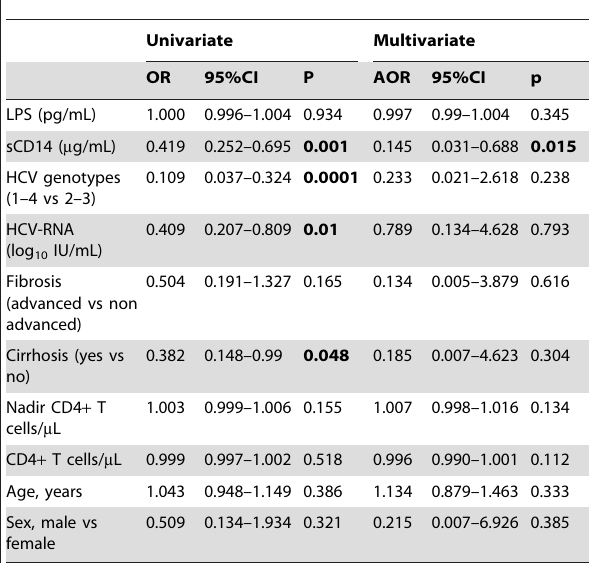
Table 3. Baseline demographic and immuno-virological characteristics of patients according SVR. Characteristics